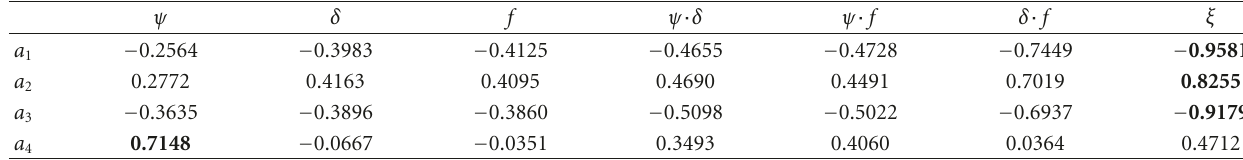
Table 2: Correlation of fitting parameters a 1 through a 4 and various configuration parameter combinations.